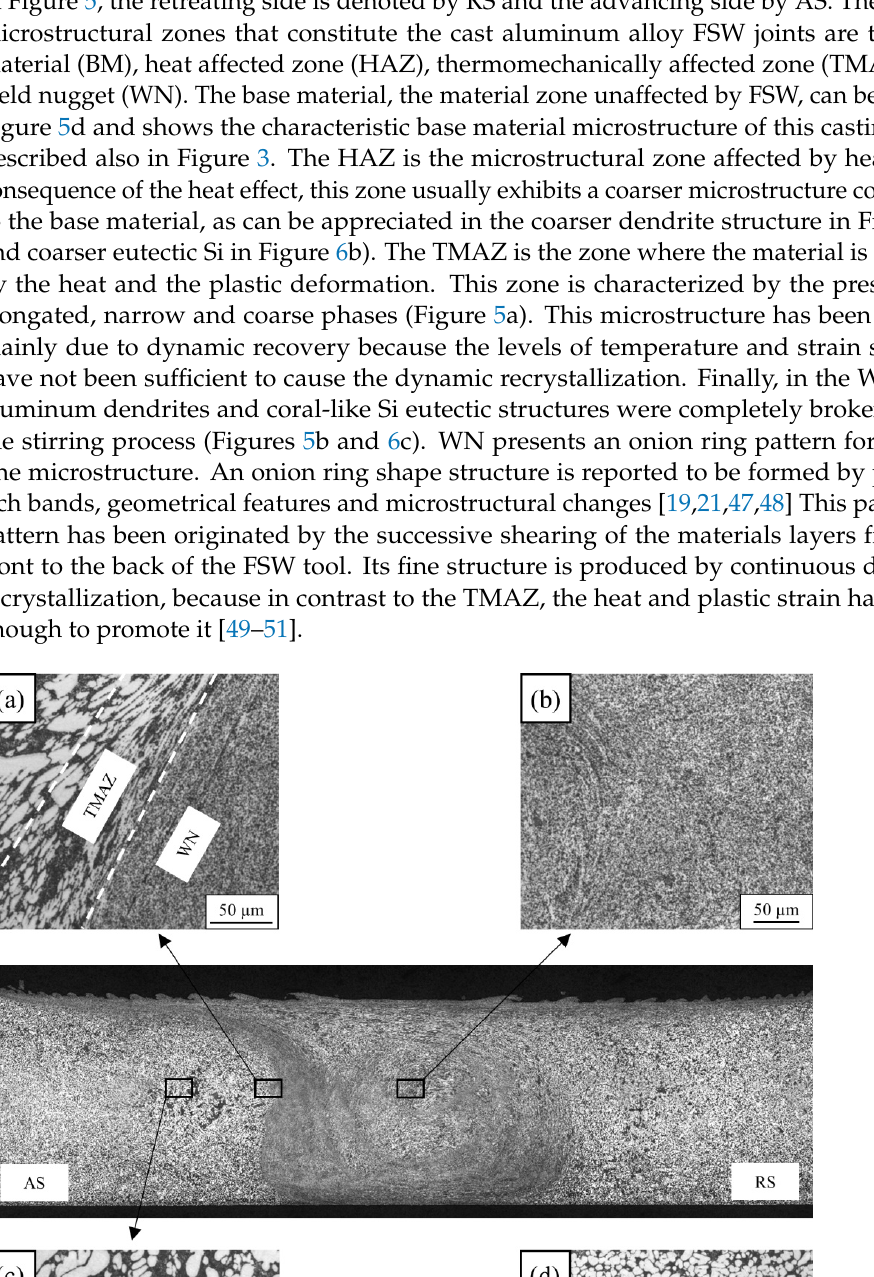
Figure 6. Detail of cross-section of AlSi10MnMg alloy at 500 mm/min: ( a ) TMAZ; ( b ) HAZ; ( c ) WN; and ( d ) base material .